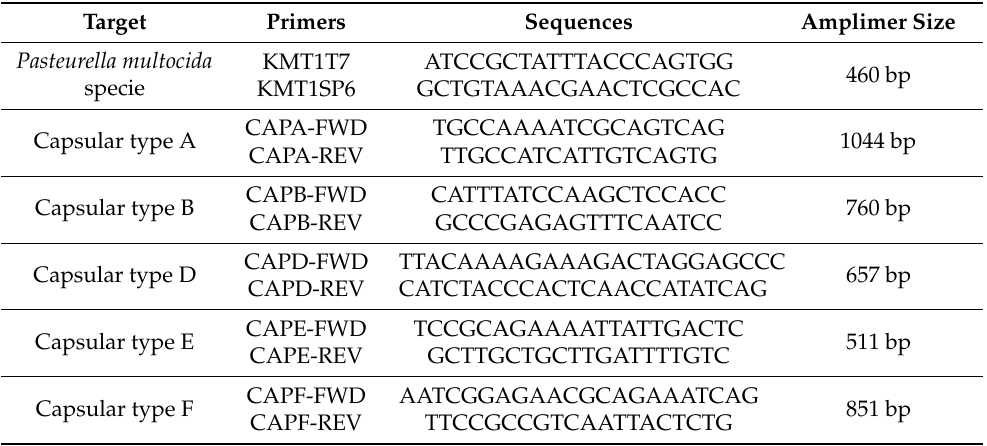
Table 1. Identification of Pasteurella multocida species and capsular type by Multiplex-PCR: Primers and corresponding oligonucleotides